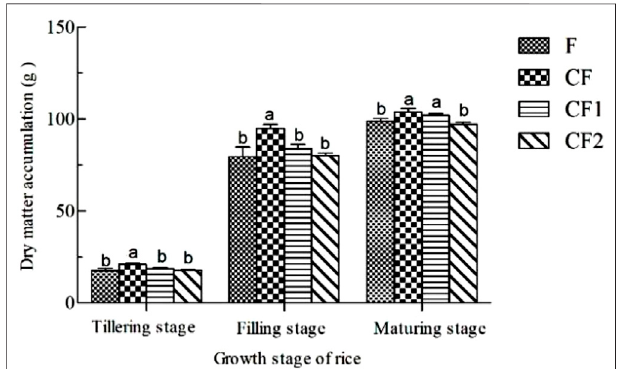
FIGURE11| Effectofco-applicationofbiocharandchemicalfertilizeron dry matter